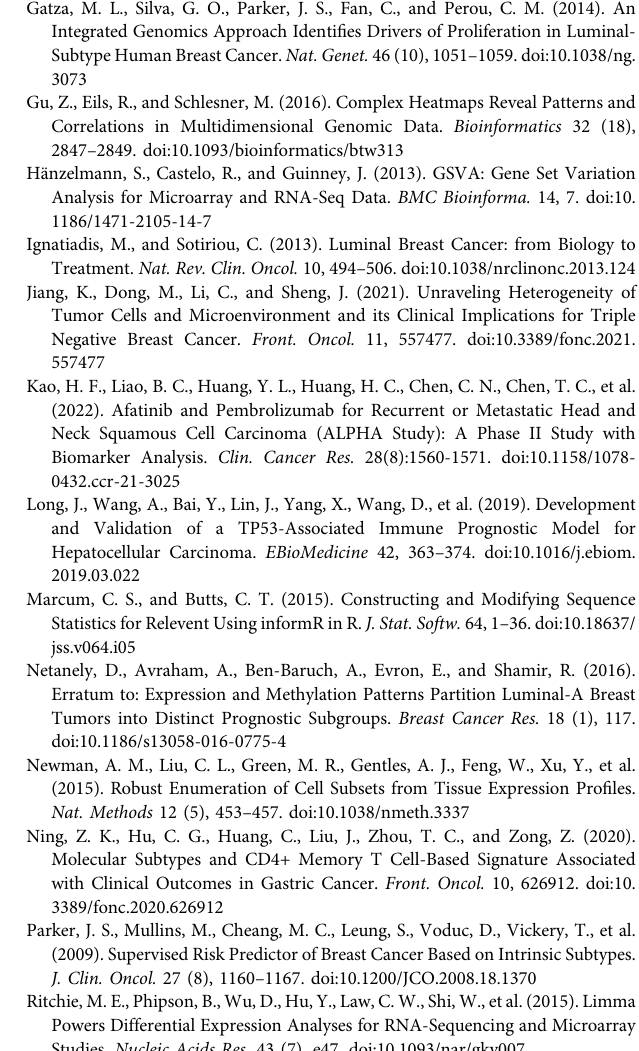
Supplementary Figure S1 | Model and selection of seven-immune-related-gene IRS. (A, B) Processes of seven immune-related gene selection by the LASSO Cox model. (C) Optimal number of clusters by the NbClust package. (D, E) Optimal number of clusters by the ConsensusClusterPlus package. IRS: immune risk Supplementary Table S1 | List of 2,600 immune-related